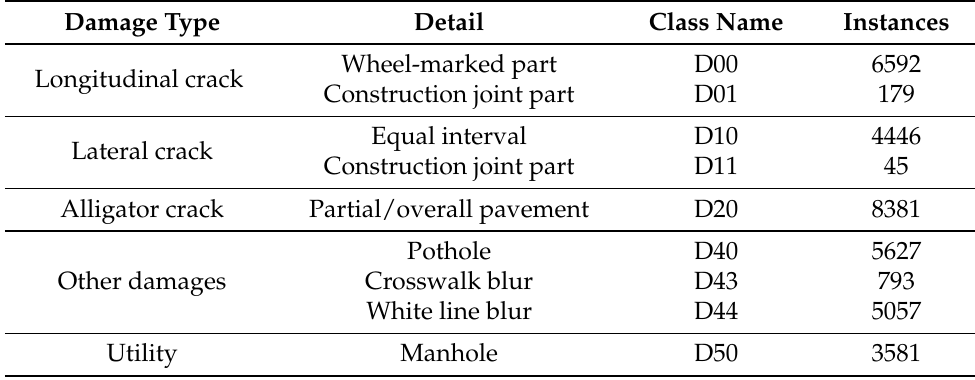
Table 2. Road damage types and definitions considered in Maeda et al. [5].